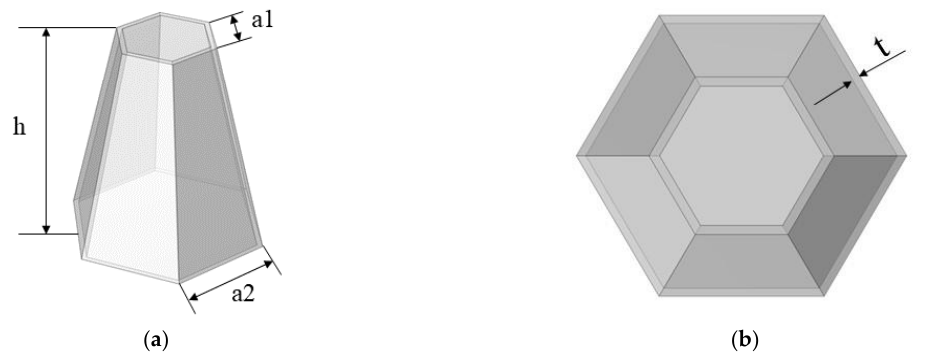
Figure 4. Geometric parameters of the honeycomb core layer: ( a ) Axonometry of the honeycomb core layer, ( b ) Enlarged view of the model.